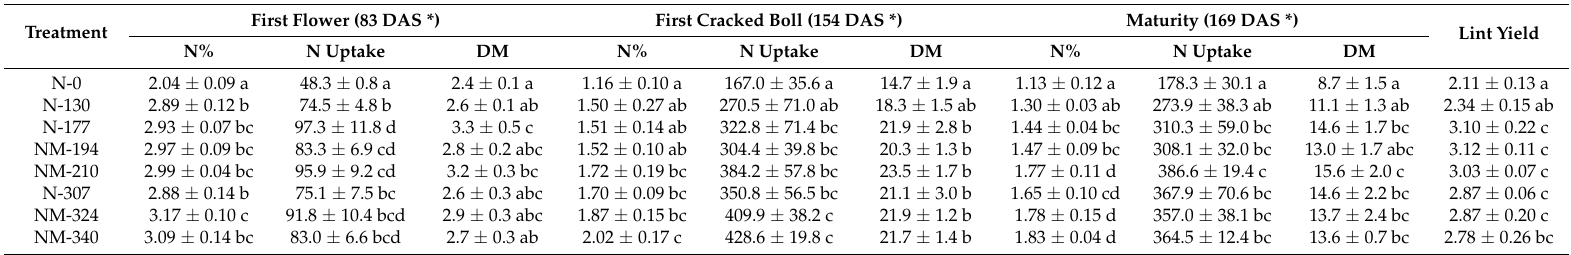
Table 3. Mean plant (above-ground part of the plant including bolls) nitrogen concentration (N%), nitrogen uptake (N uptake, kg N ha − 1 ) and dry mass (DM, t ha − 1 ) for each fertilization treatment at first flower, first cracked boll and maturity. Average lint yield (t ha − 1 ) obtained at harvest is also shown. Treatment